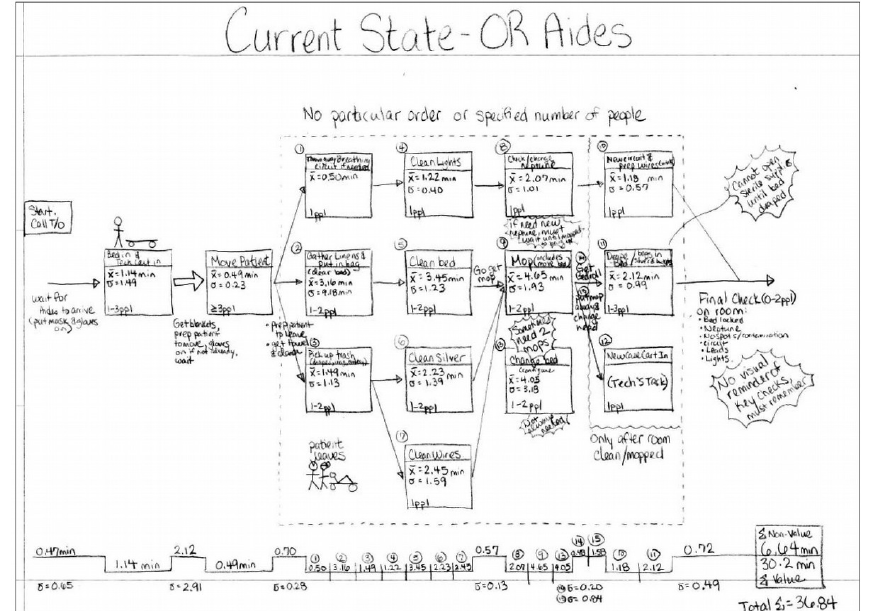
Figure 3. OR Aide Current State Value Stream Map